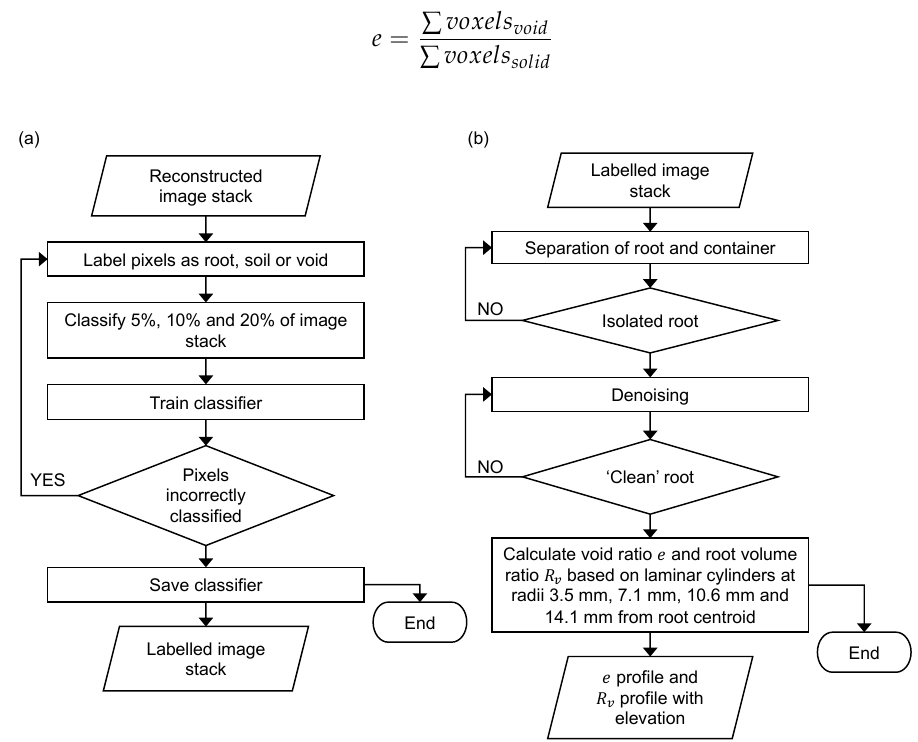
Figure 3. Flow charts representing the algorithmic steps of: ( a ) automatic classification process using deep learning ( b ) the MATLAB parameter quantification process.